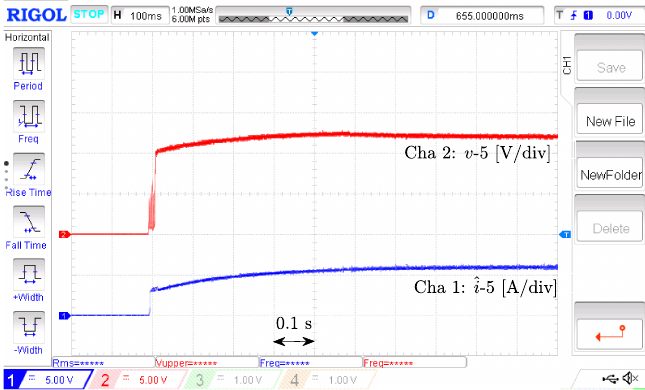
Figure 9. The transient of boost converter under the PI controller.